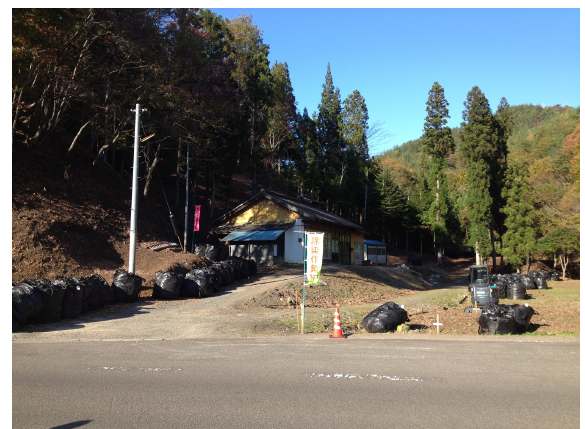
Figure 4. Illustration of the 20m decontaminated buffer zone in forested areas in the vicinity of houses. Example from Iitate village (Sasu